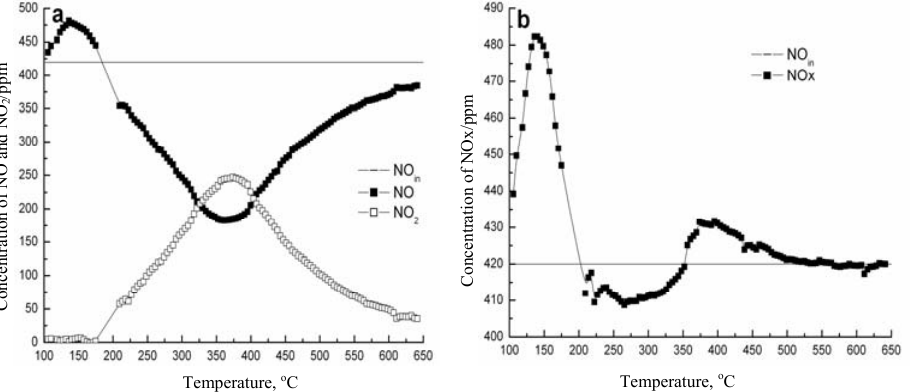
Figure 7. TPR profiles of NO, NO